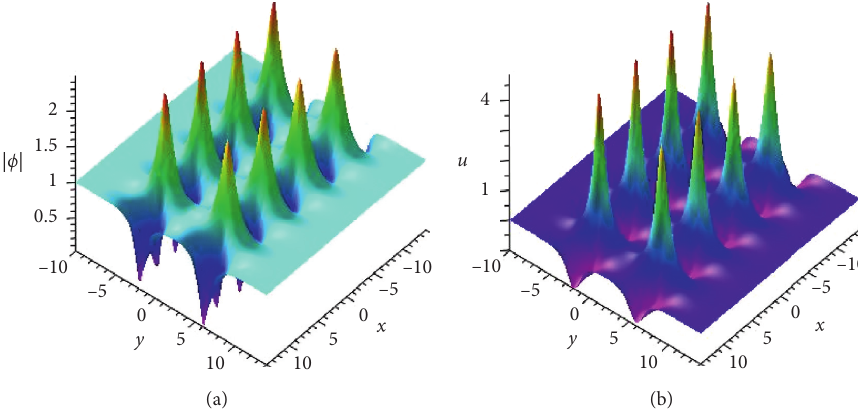
Figure 2: The two-breather solutions | ϕ | and u of the nonlocal Mel ′ nikov equation with parameters N � 4 ,P P � − 1 , κ � 1/2 , Q 4